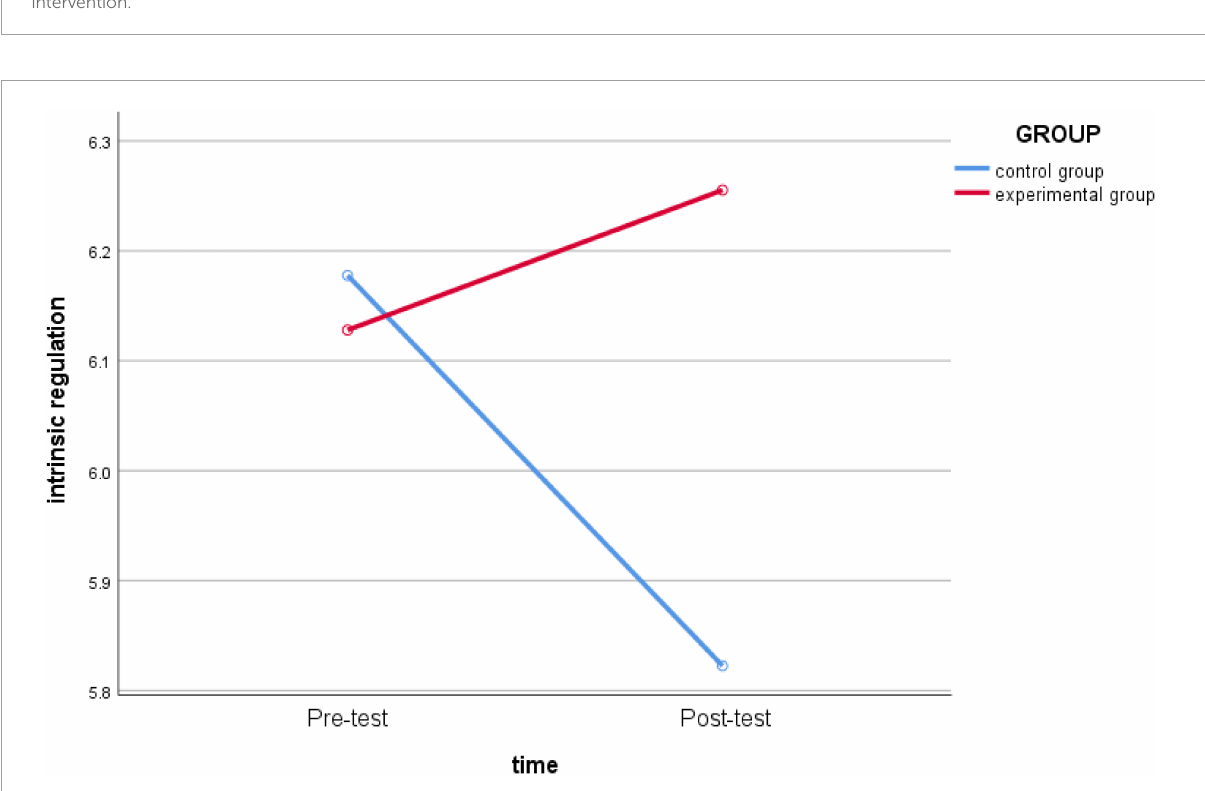
FIGURE5 Schematic diagram of changes in intrinsic regulation between the experimental group and the control group before and after